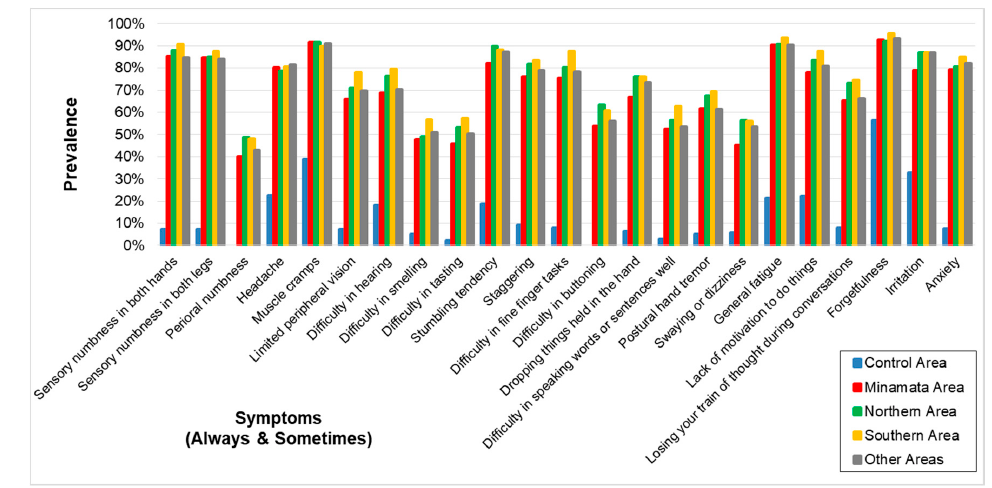
Figure 3. Prevalence of symptoms (Always and Sometimes) in each area. Prevalence was higher in the four exposed groups than that in the control area. The symptomatic patterns were similar among the four groups. Table 6. Correlation of prevalence of symptoms (Always and Sometimes) among each area. Correlation/( p -Value) Control Area Minamata Area Northern Area Southern Area